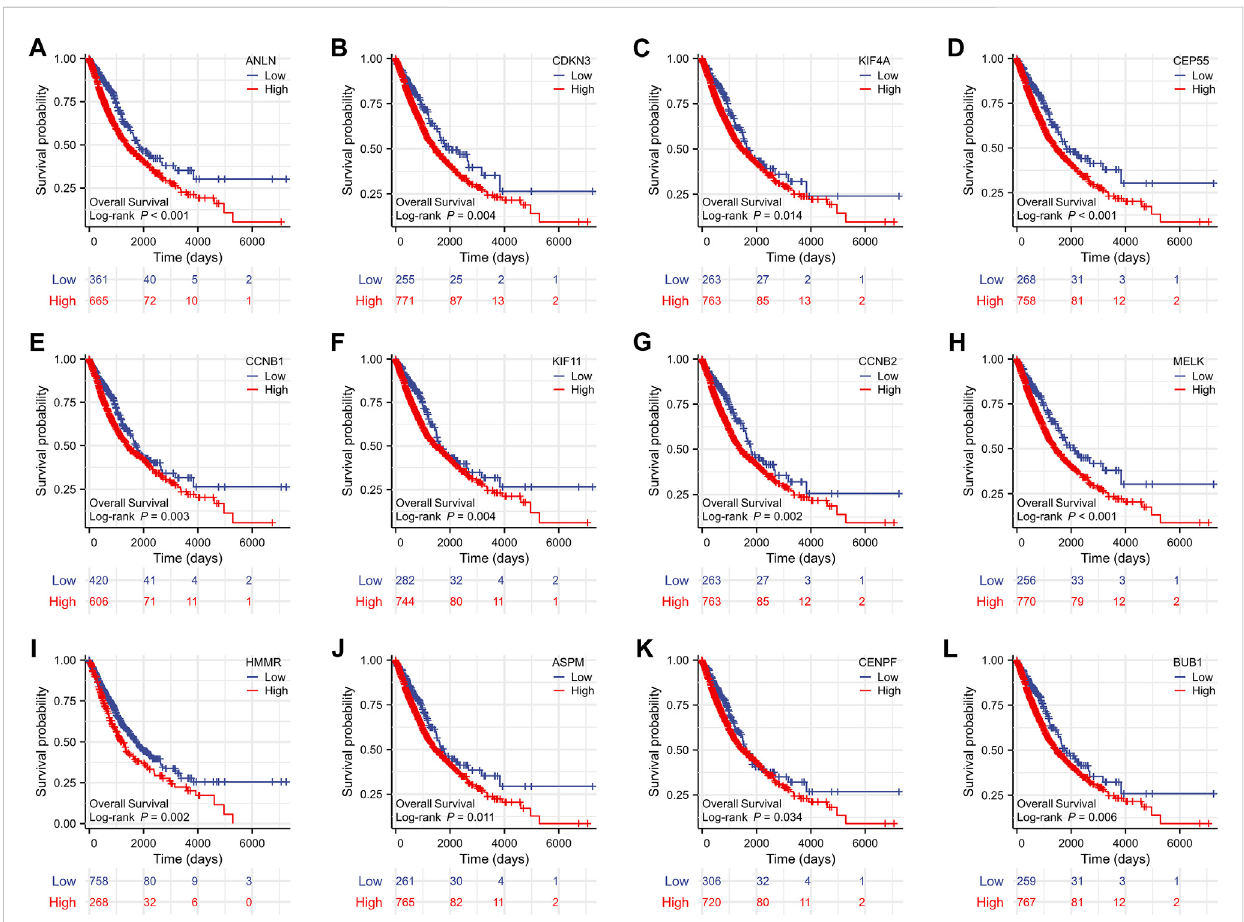
FIGURE 8 Theoverallsurvivalanalysesofthe12keygenes (A-L) performedbyRsoftwareusingtheRNAseqdataofNSCLCintheTCGAdatabase.NSCLC,non- small cell lung